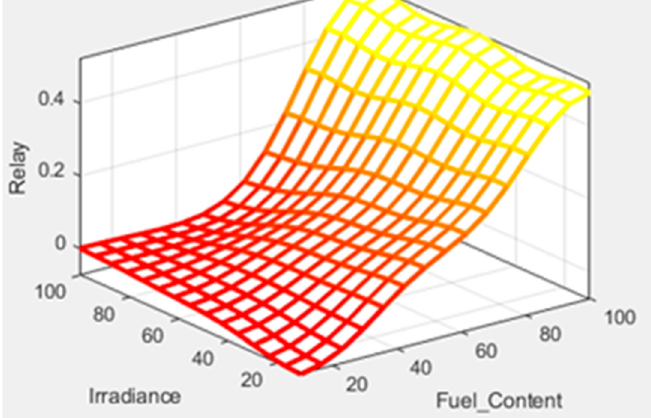
Figure 38. Surface representation of the variable irradiance, fuel content and Relay.